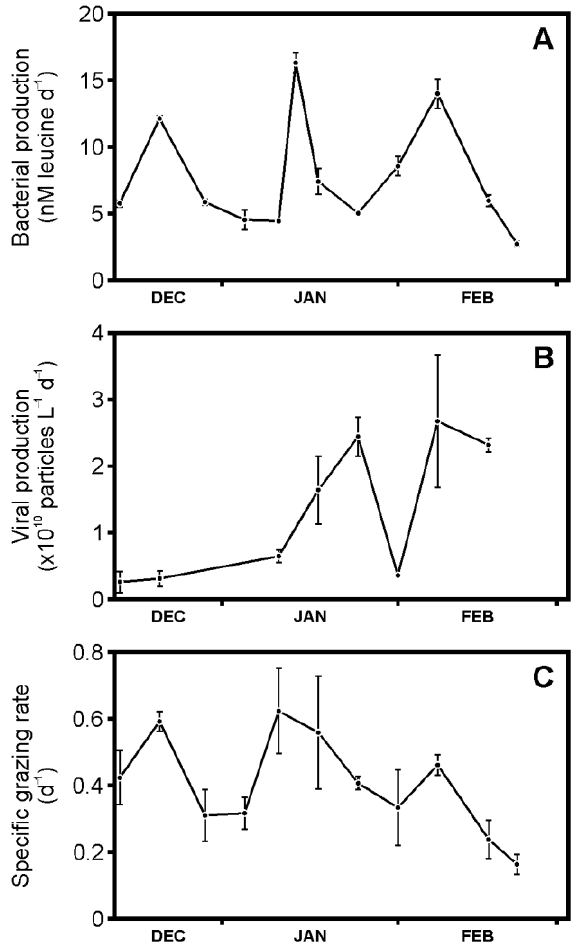
Figure 3. Rates of microbial processes mediating carbon flow during the austral summer (December 2010 to February 2011) at the western Antarctic Peninsula sampling site at a water depth of 15 m: ( A ) leucine incorporation, ( B ) viral production, and ( C ) specific heterotrophic nanoflagellate (HNF) grazing